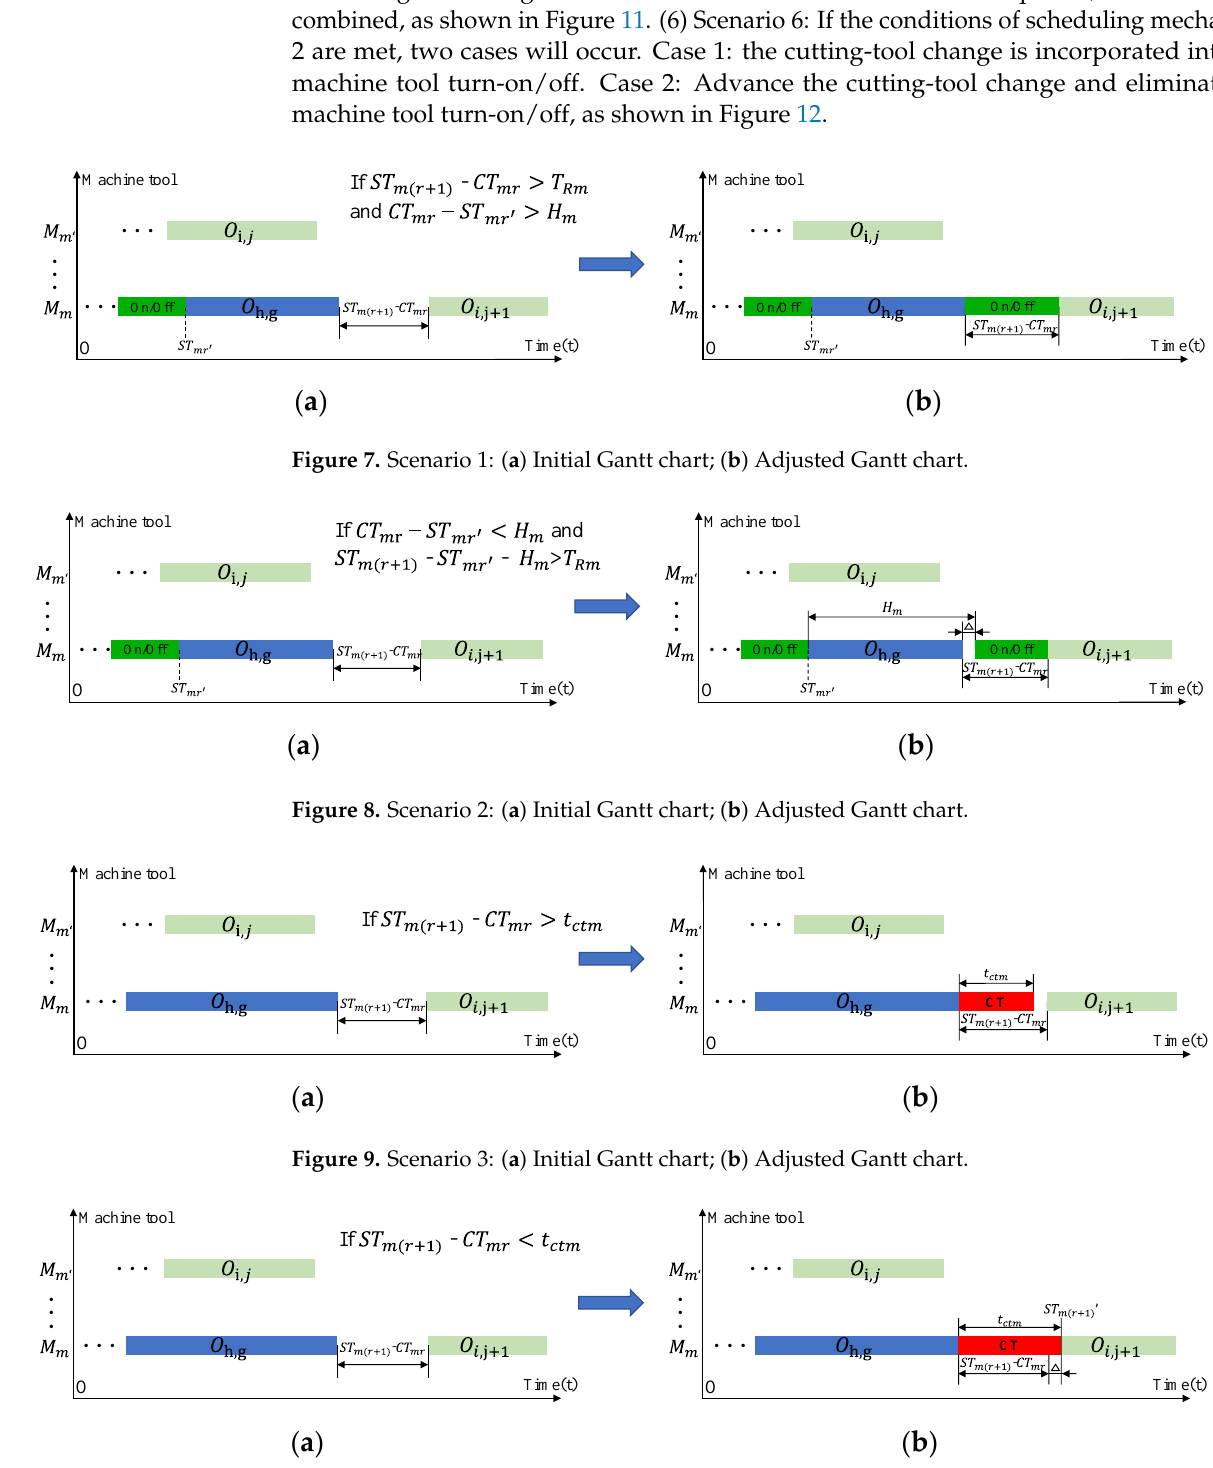
Figure 10. Scenario 4: ( a ) Initial Gantt chart; ( b ) Adjusted Gantt chart.